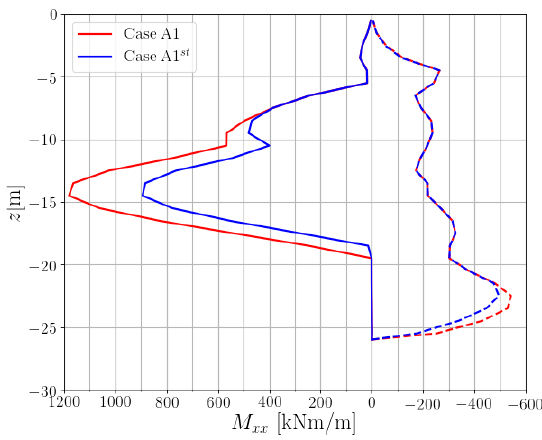
Figure 6: Comparison of characteristic bending moment envelopes (Case A1 only) based on all time instances registered until the last excavation step and then until the time instance at which the foundation raft is